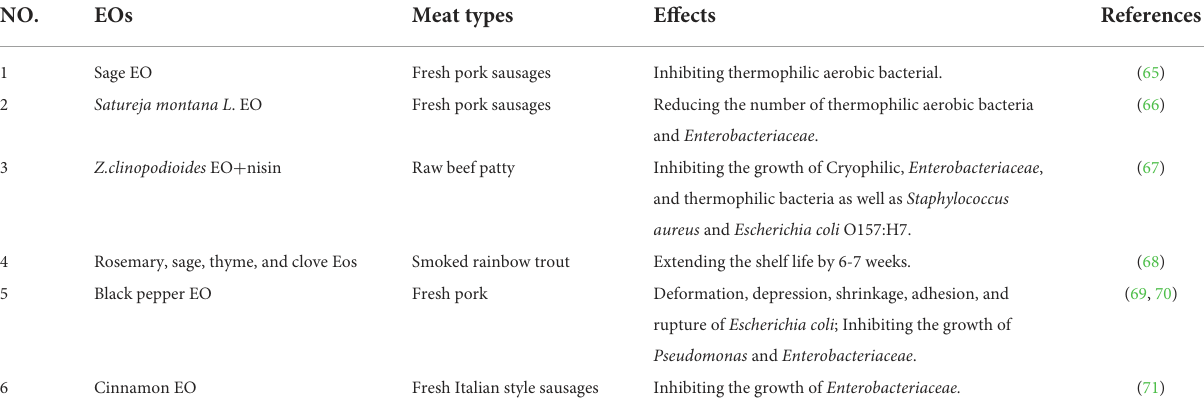
TABLE 3 List of common plant EOs effects on spoilage bacteria in meat products and fish